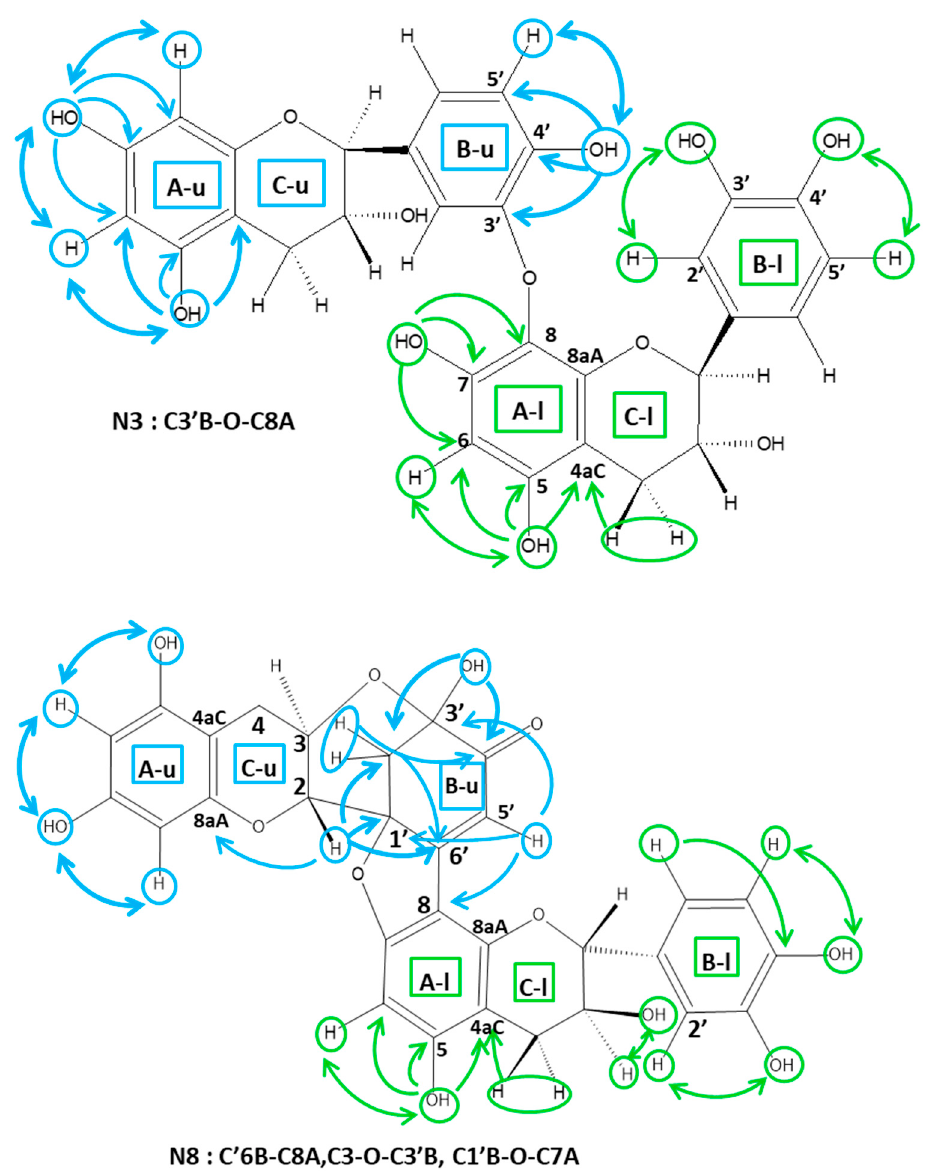
Figure 5. Scheme of catechin dimers (N2, N3, and N8) showing main 1 H/ 13 C long-range and 1 H/ 1 H ROE correlations, allowing linkage position determination. Blue arrows: upper unit. Green arrows: Lower units. Single arrows: HMBC correlations. Double arrows: ROEs correlations. A, B, C rings are labelled with u for upper units and with l for lower units.